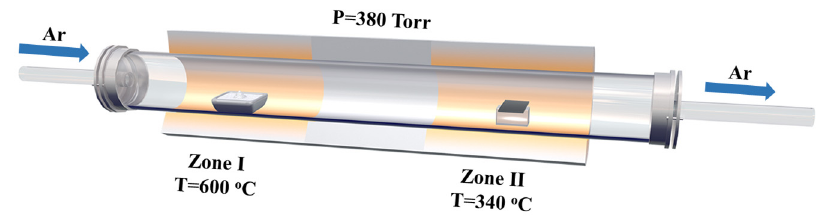
Figure 1. Schematic diagram of the CVD system.